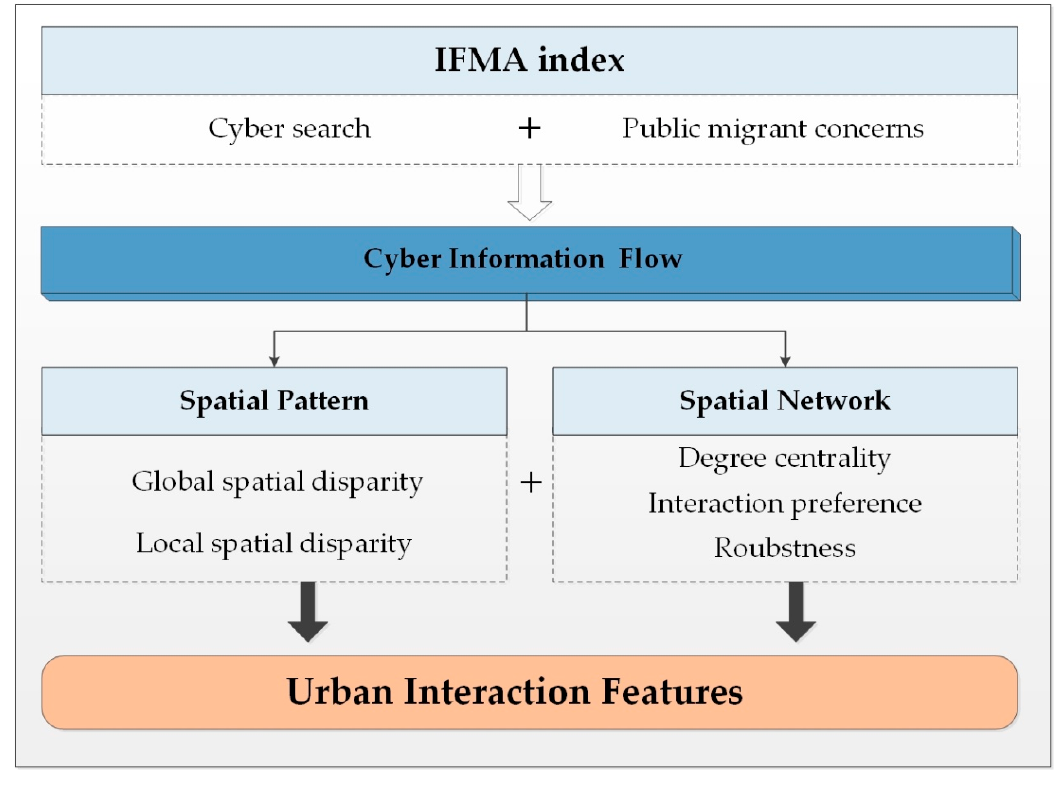
Figure 2. Research framework.